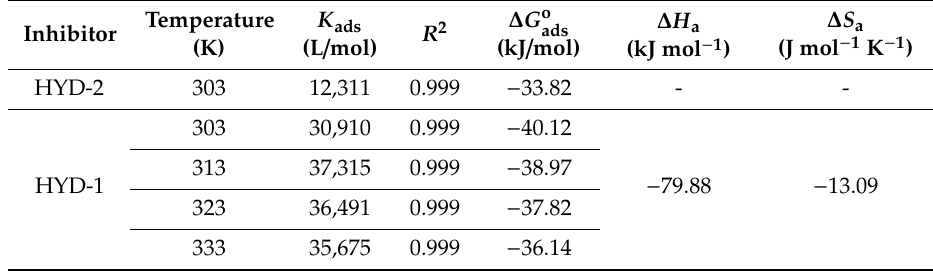
Table 6. Thermodynamic parameters of mild steel corrosion in 1.0 M HCl solution with the presence of HYD-1 and HYD-2. Temperature Inhibitor